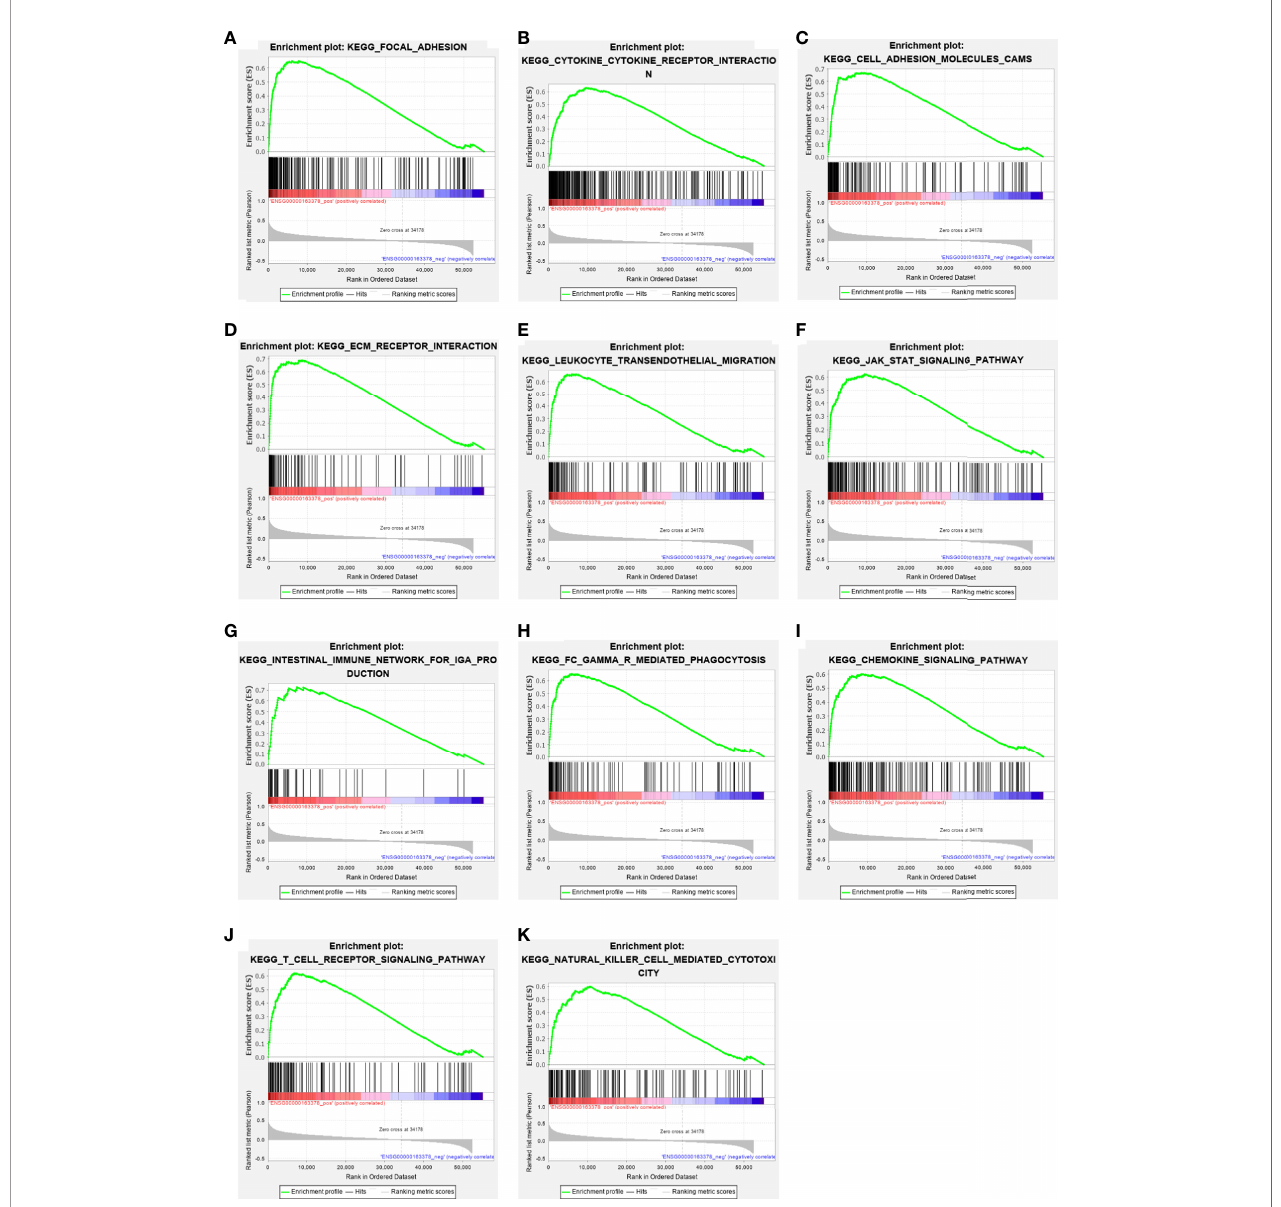
FIGURE 6 | The enrichment results of GSEA. Upregulated ERGs were positively correlated with “ focal adhesion ” (A) , “ cytokine – cytokine receptor interaction ” (B) , “ cell adhesion molecules ” (C) , “ ECM receptor interaction ” (D) , “ leukocyte trans-endothelial migration ” (E) , “ JAK – STAT pathway ” (F) , “ intestinal immune network for IgA production ” (G) , “ Fc gamma R-mediated phagocytosis ” (H) , “ chemokine signaling pathway ” (I) , “ T-cell receptor signaling pathway ” (J) , and “ natural killer cell- mediated cytotoxicity ” (K)